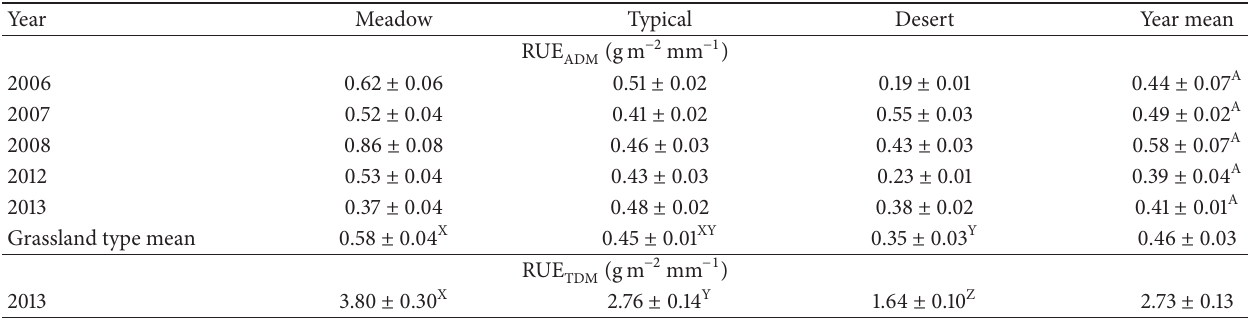
Table 1: Differences in RUE ADM and RUE TDM (g m − 2 mm − 1 ) between grassland type and precipitation years.